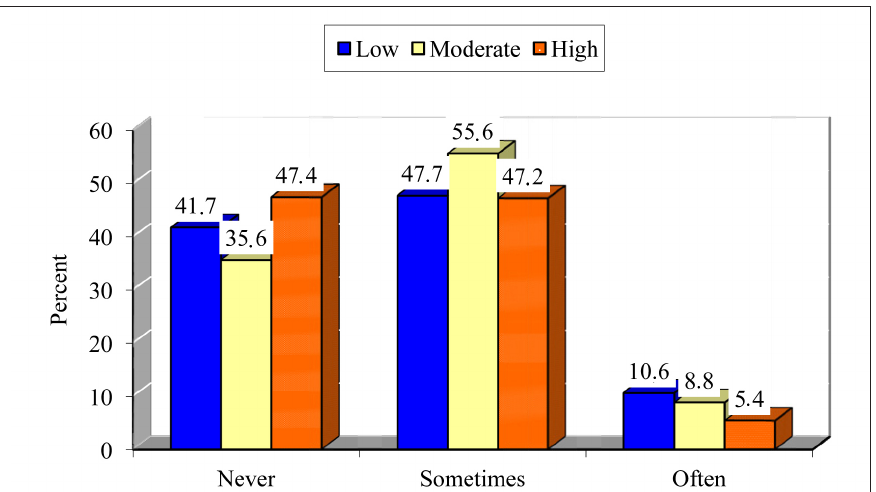
Figure 2. Percentage distri- bution of bullying initiated